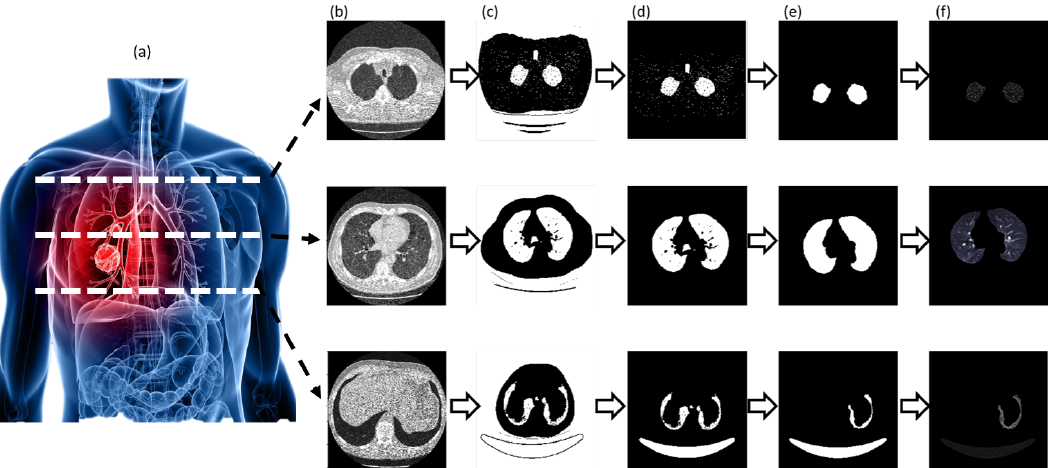
Figure 3. Sample results of segmented results of a top slice, middle slice, and bottom slice of a lung image of a